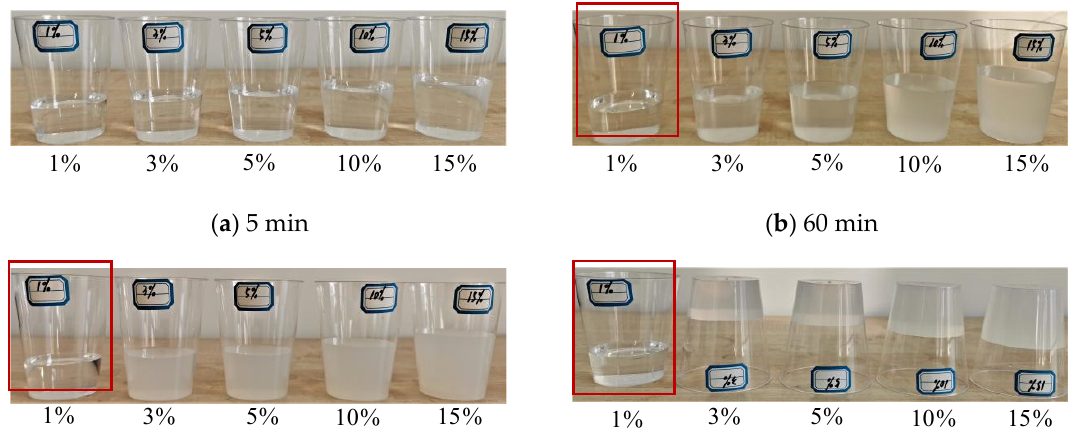
Figure 2. The effects of acetic acid concentration on the stability of the precursor solutions of NS.